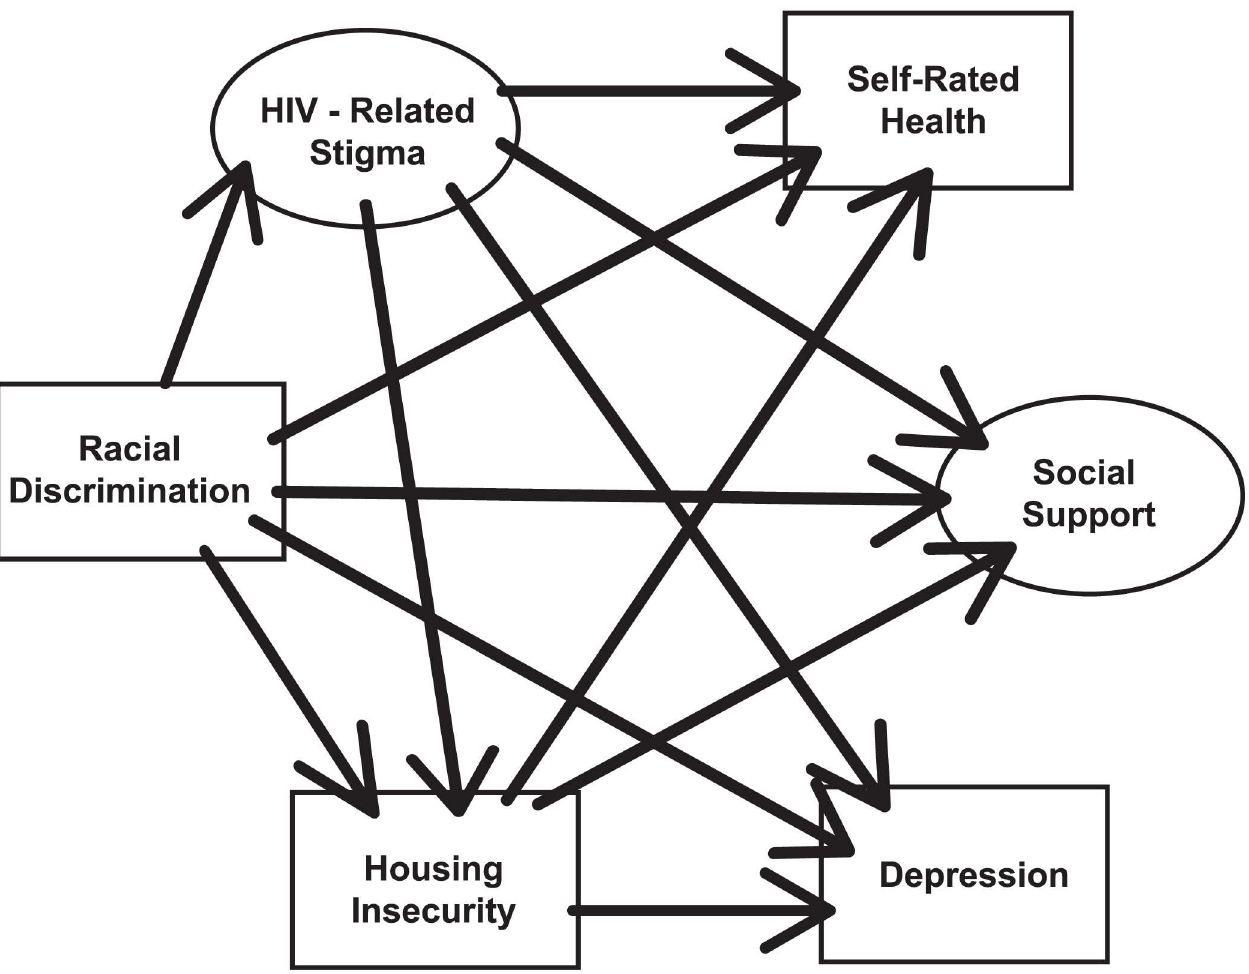
Fig 1. Tested conceptual model of the relationship between HIV-related stigma, racial discrimination, housing insecurity and wellbeing among African and Caribbean women living with HIV in Ontario. Fig 1 depicts hypothesized relationships between variables analyzedin the model. Solid lines represent hypothesizeddirect effects. Ovals represent latent variables, and rectanglesrepresent observed variables.